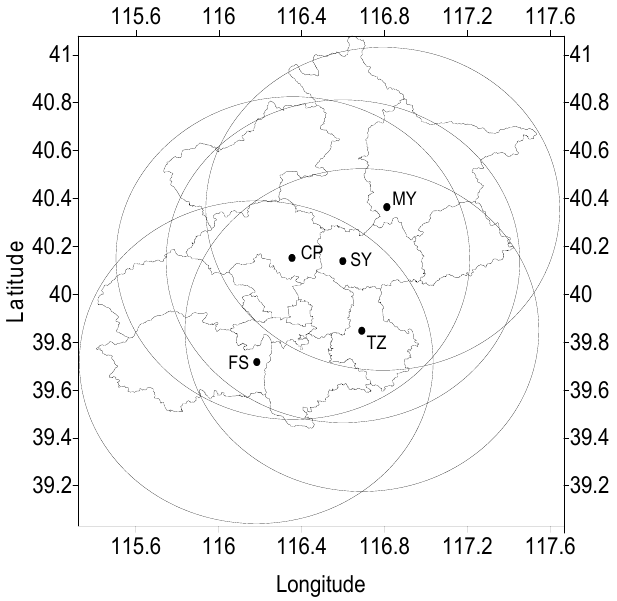
Figure 2. The layout of the dual-polarization X-band radars (75 km range rings). The letter symbols, such as “CP”, correspond to the name of various